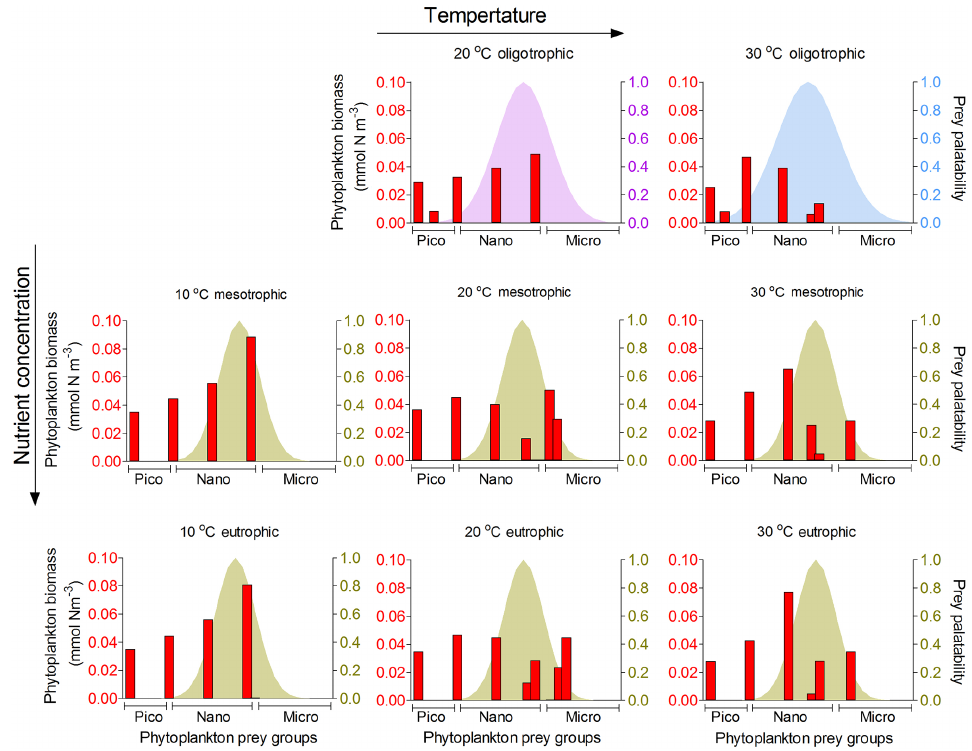
Figure 9. Model results of resource competition for the adult stage (20µm) of planktonic foraminifera in the food web version. Left axis (red columns): biomass (mmolNm − 3 ) of phytoplankton size groups. Right axis (coloured shadow): prey palatability of planktonic foraminifera. For oligotrophic environments, σ = 0 . 8 (violet) and 1 (light blue) for 20 and 30 ◦ C, respectively. For all meso- and eutrophic ecosystems σ = 0 . 6. No zooplankton larger than 100µm and adult stage of planktonic foraminifera survived in the oligotrophic ecosystem at 10 ◦ C for the model set-up. A total of 6 pico- (0.6–2.0µm), 10 nano- (2.6–20µm) and 9 microplankton groups (25–160µm) are included in the model